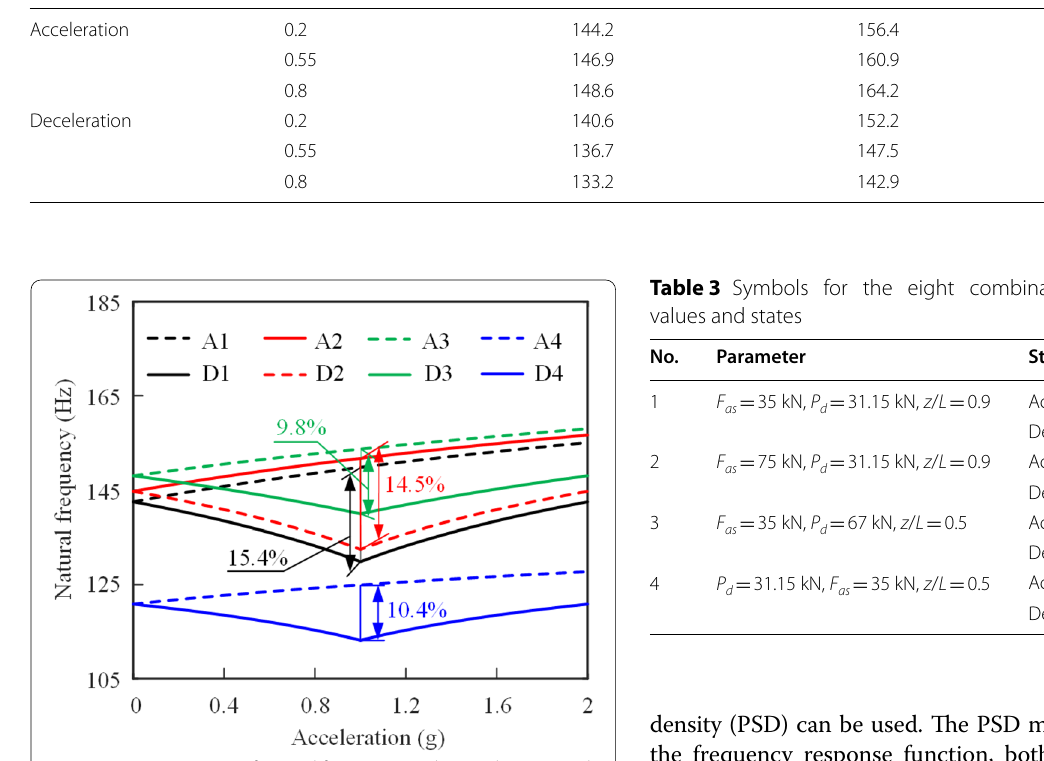
Figure 10 Comparison of natural frequency under acceleration and deceleration as a function of P d , F as , z / L